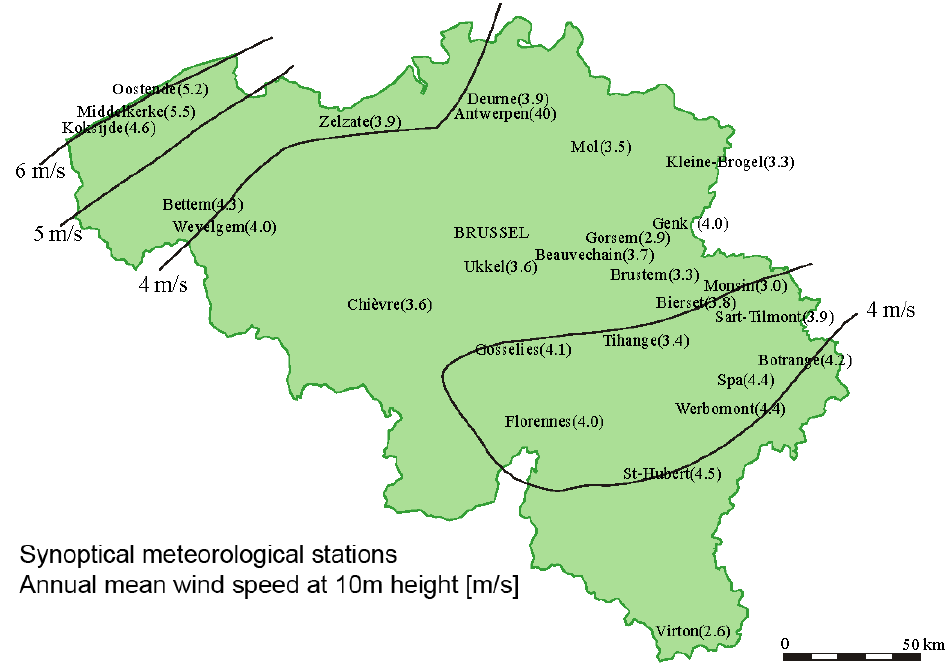
Figure 1. Annual mean wind speed map of Belgium